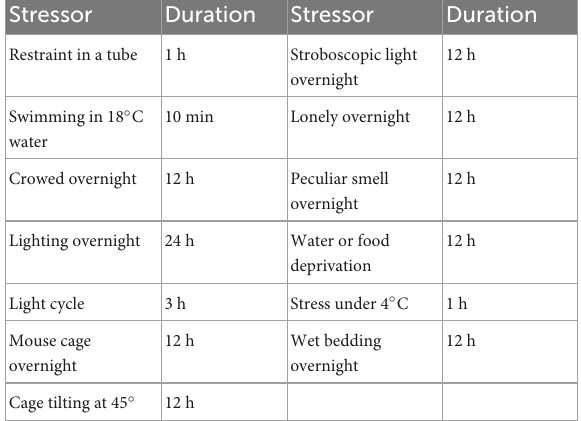
TABLE 1 The stressors for CUMS in this